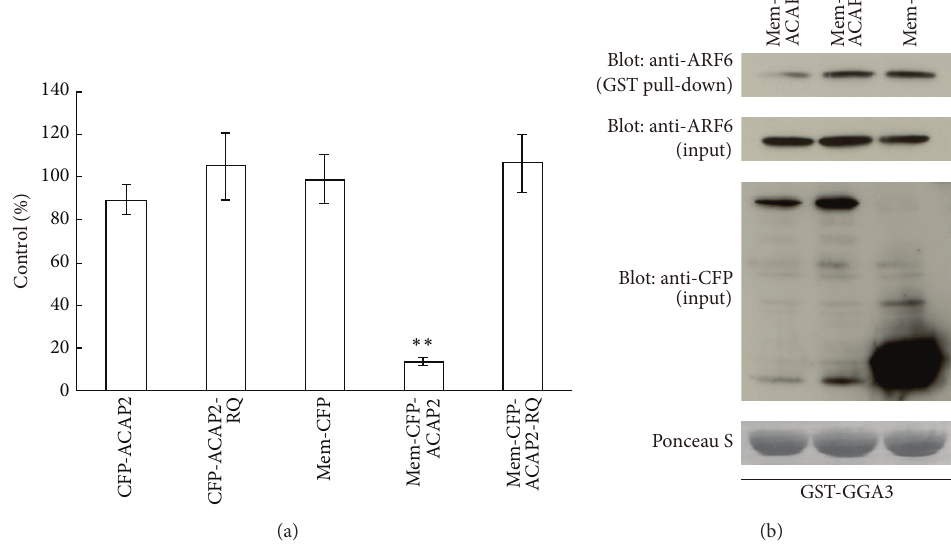
Figure 6: Plasma membrane-targeted ACAP2 inhibits zymosan uptake through ARF6 inactivation. (a) Quantification of zymosan phagocytosis in cells expressing several CFP-ACAP2 mutants was conducted. The number of formed phagosomes was counted under the microscope. The efficiency of phagocytosis was calculated based on 50 transfected and 50 untransfected cells. The results are expressed as a percentage of control (untransfected) cells. The data are means ± SEM of three independent experiments. It is of note that the expression of plasma membrane-targeted ACAP2 dramatically reduces phagosome formation. Student’s 𝑡 -test was used for statistical analysis. ∗∗ 𝑝 < 0.001 compared to Mem-CFP. (b) Levels of endogenous ARF6 activation were determined in RAW264 cells expressing Mem-CFP-ACAP2 or Mem- CFP-ACAP2-RQ. Cell lysates were prepared and incubated with GST-GGA3. The proteins associated with GST-GGA3 were pulled down using glutathione-sepharose beads. GTP-ARF6 (top panel), total ARF6 (second panel), and CFP fusion proteins (third panel) were detected by immunoblotting. GST-GGA3 was stained with Ponceau S (bottom panel). Note that the expression of plasma membrane-targeted ACAP2 impairs ARF6 activation. Similar results were obtained from three independent